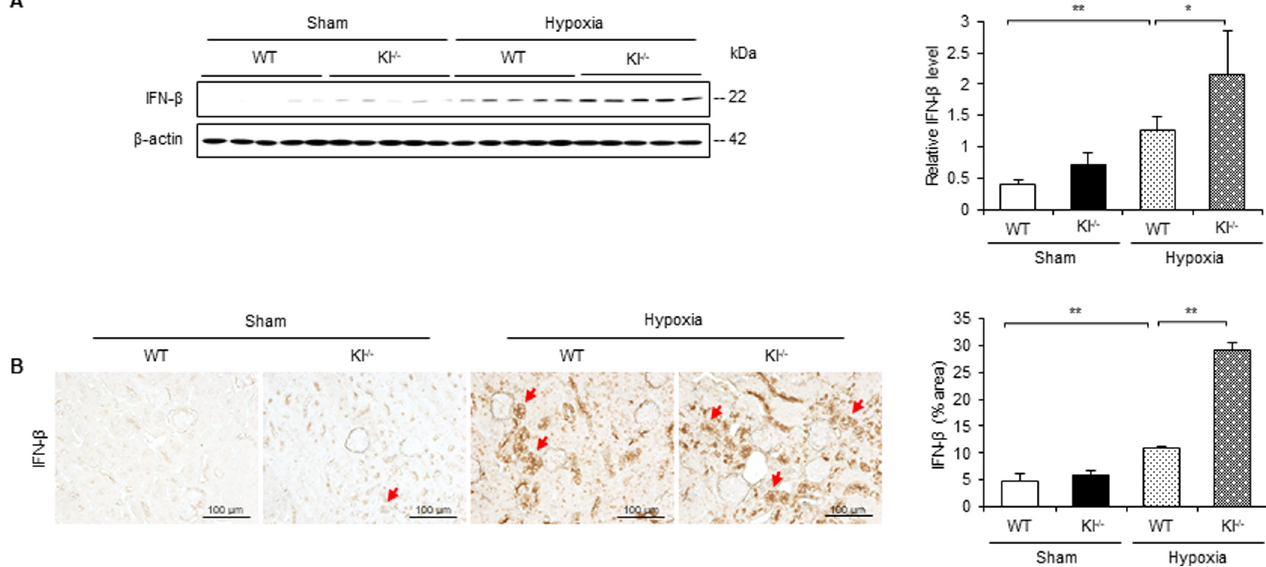
Fig 7. IFN- β is increased under hypoxic conditions in Kl − / − mice. (A) Western blot analysis demonstrating IFN- β expression in WT and Kl − / − mice. Protein levels were normalized to β -actin levels (n = 5 in each group). (B) Representative immunohistochemical staining images showing IFN- β expression in WT and Kl − / − mice. Values are mean ± SD. � P < 0.05, �� P < 0.01. Bar = 100 μ m.